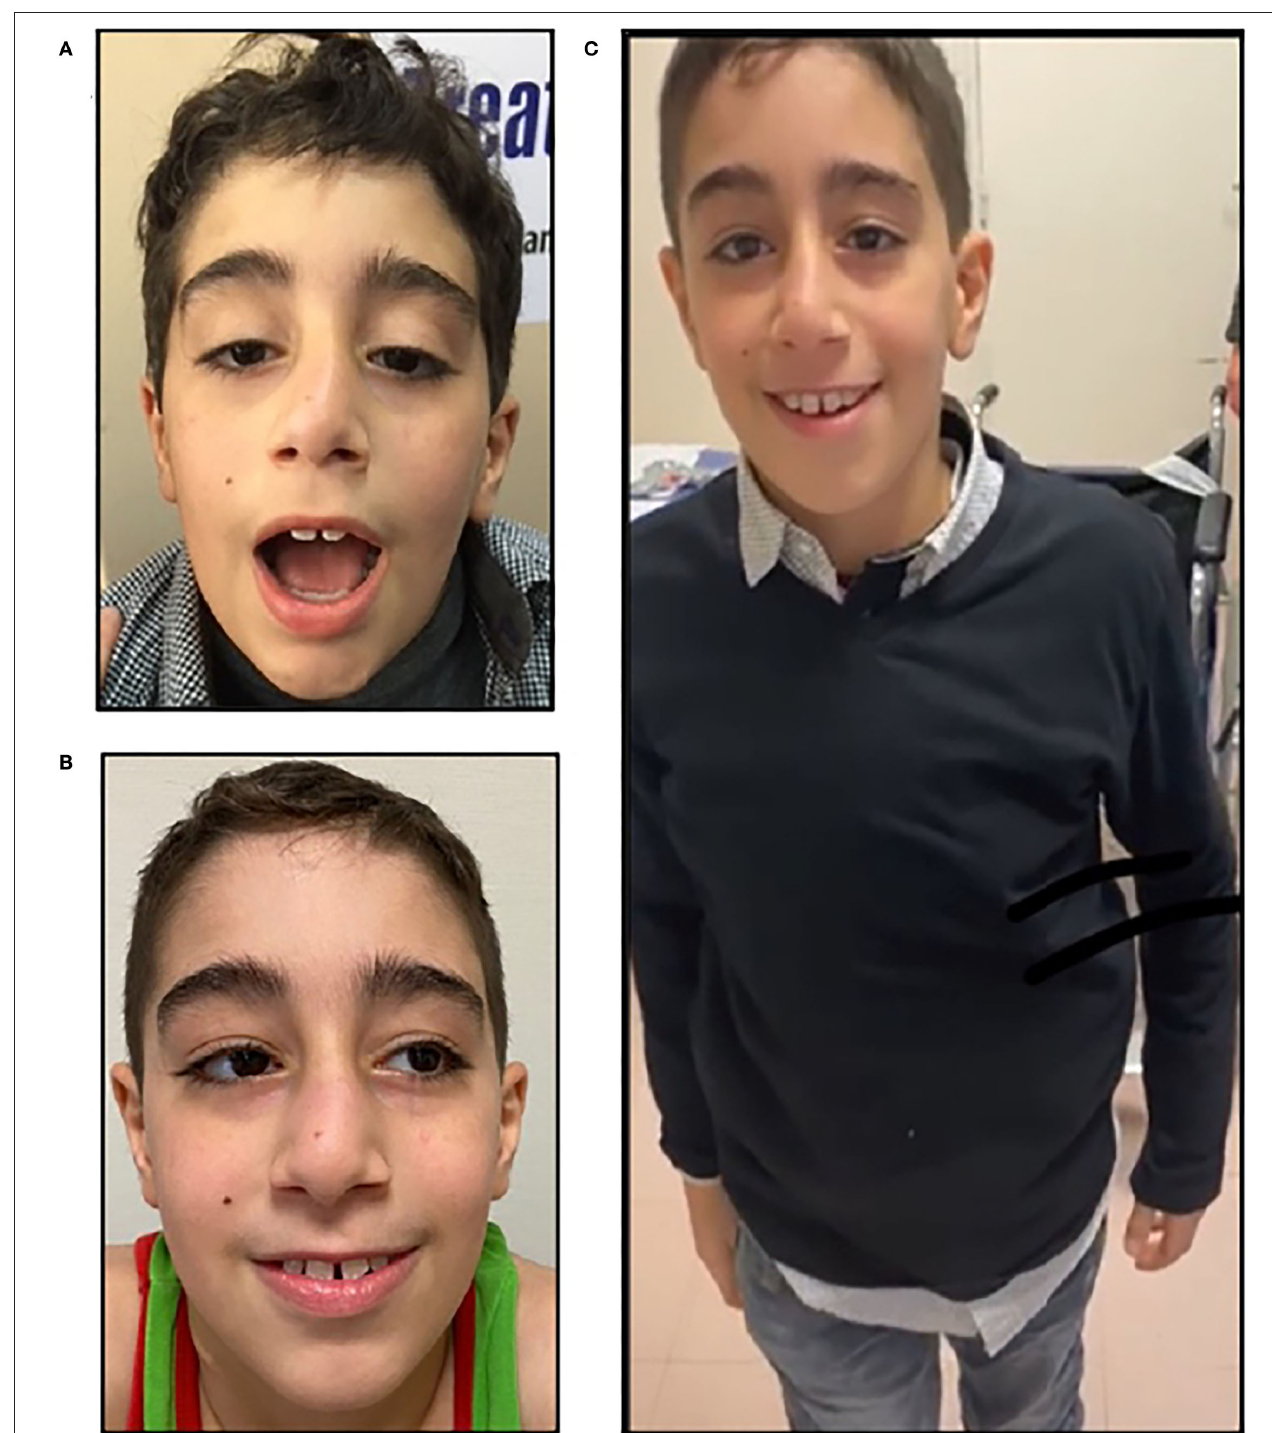
FIGURE 1 | Clinical features, P1. P1, an 11-year-old boy with before treatment with salbutamol, showing severe bilateral ptosis and facial weakness (A) ; note the improvement after salbutamol treatment; he showed only mild ptosis (B) and less fatigability, being able to walk without aid (C) . may trigger nonsense-mediated decay of CHRNE mRNAs. Such This variant predicts a shift in a translation reading frame, a a homozygous frame shift in the CHRNE gene results in low change of glycine 212 to arginine, and a premature stop codon expressor-type at Codon 214 ( Figure 3 ). This premature termination codon